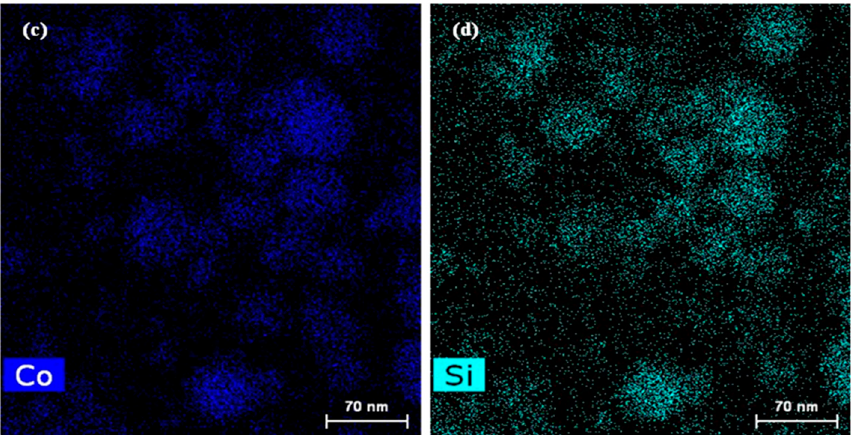
Figure 8. Area scanning images of the element distribution for the HADDF Z-contrast image of Figure 7b: ( a ) Cu; ( b ) Ni; ( c ) Co; ( d ) Si.